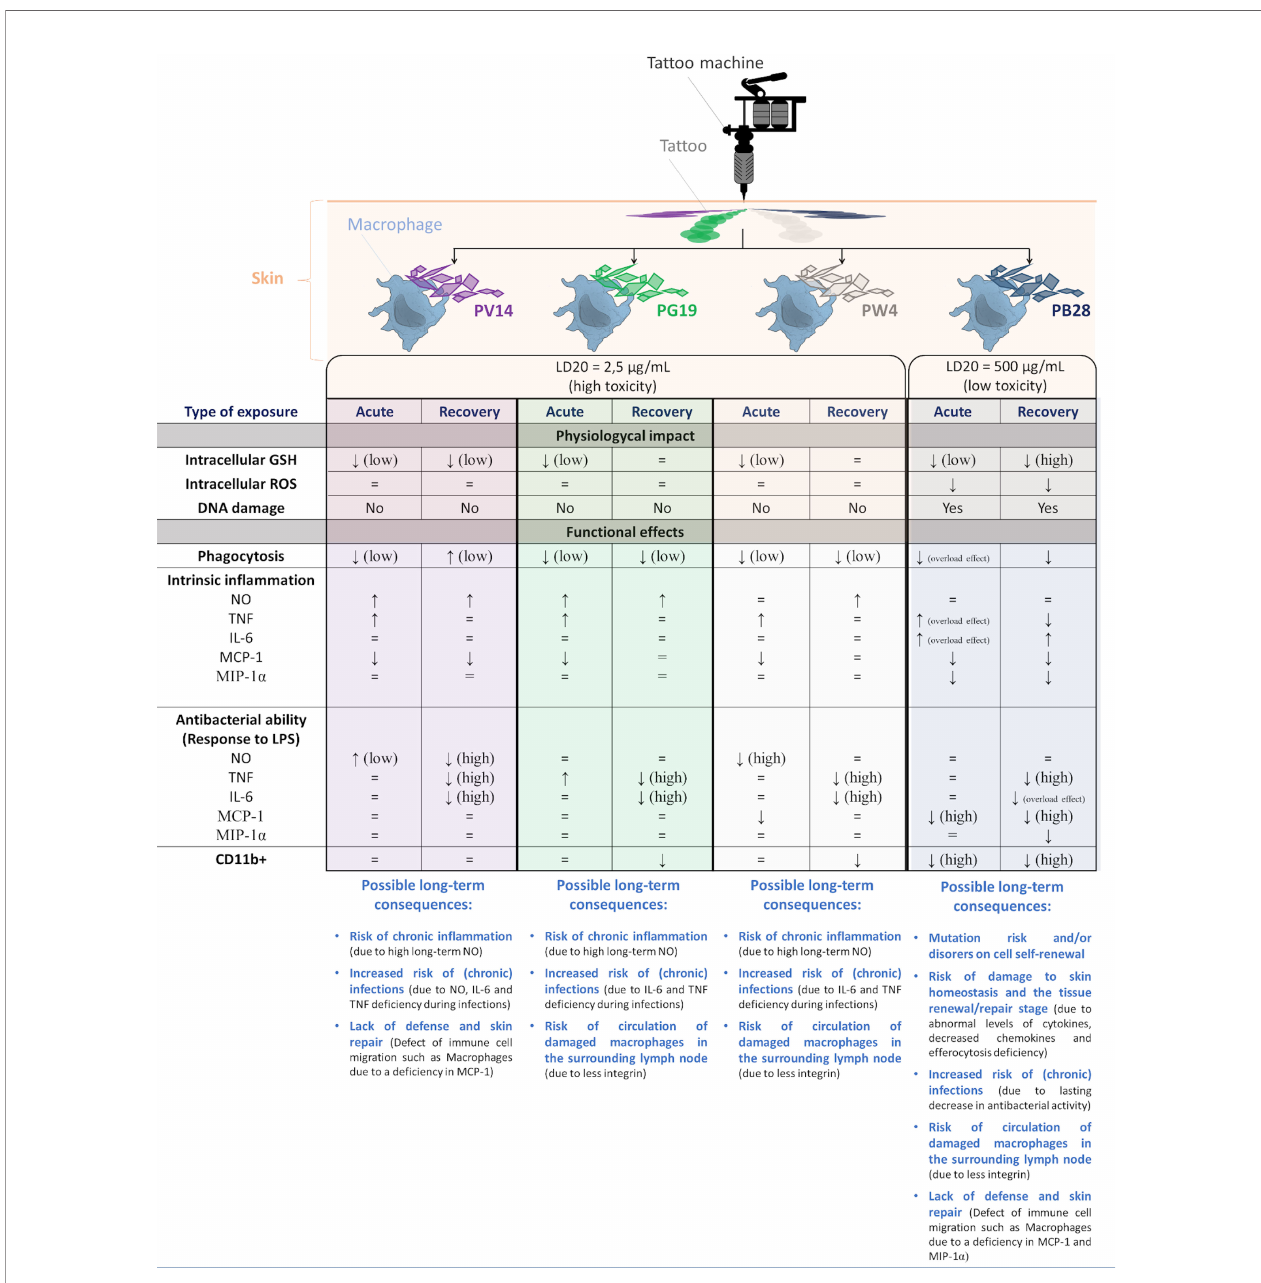
FIGURE 15 | Summary fi gure of the results obtained and possible consequences on the skin for the different inks tested. Signi fi cance of symbols:= no differences; ↓ decrease in comparison to controls; ↑ increase in comparison to